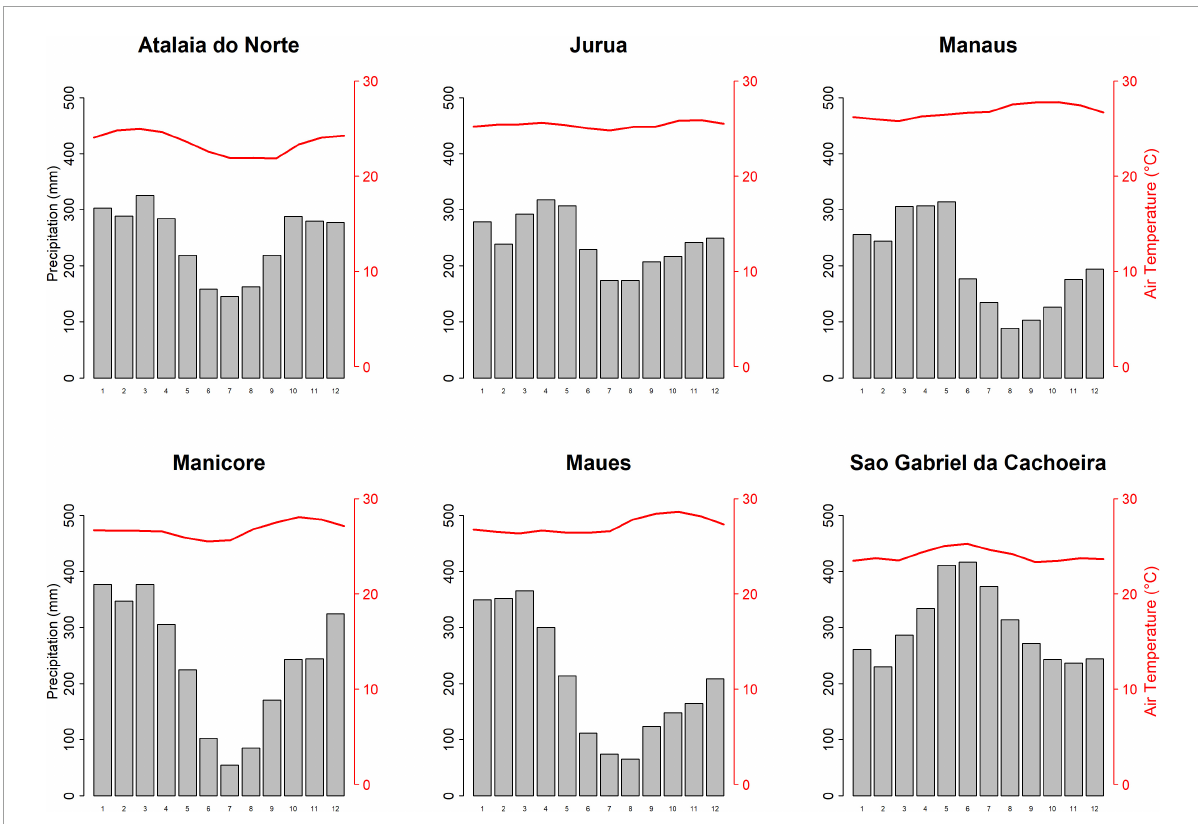
FIGURE2 Seasonal distribution of monthly mean precipitation (gray histogram) and temperature (red line) at each study site [adapted from Alvares et al. (2013)].